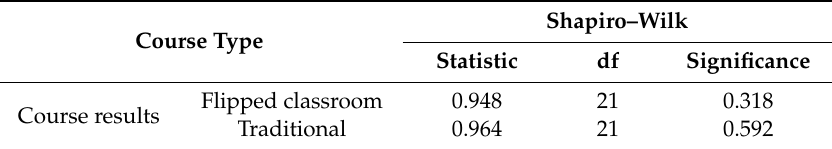
Table 6. Student learning outcomes—Shapiro–Wilk test